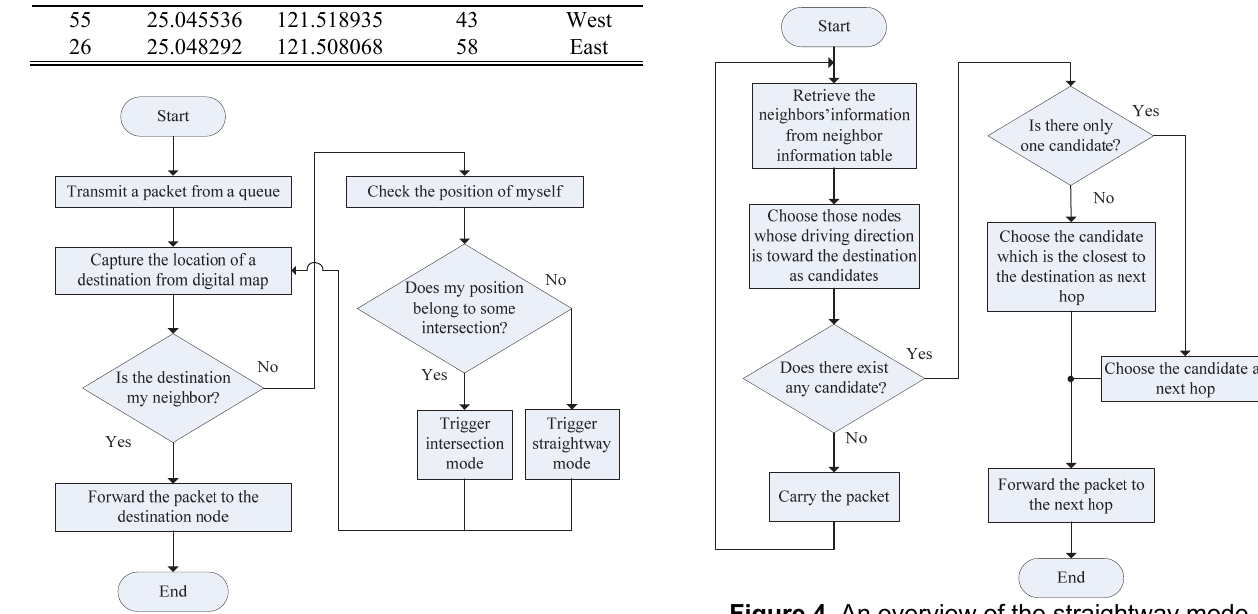
Figure 3. Routing process